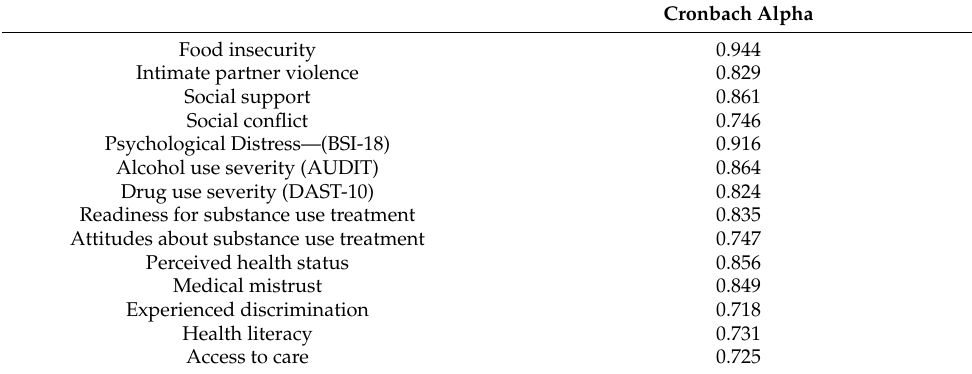
Table 2. Reliability of continuous scales used to measure barriers to